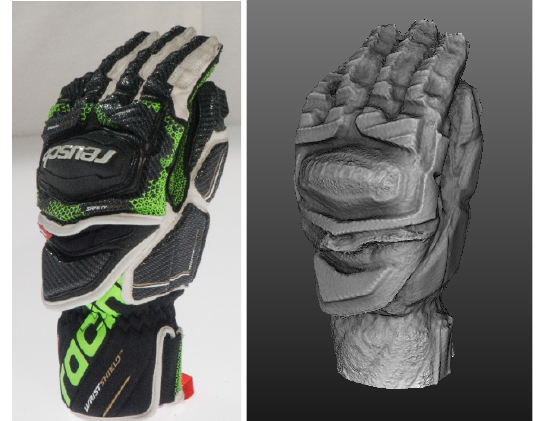
Figure 13: One (out of 93) image of a glove obtained by rotating the system basement around the Z axis (left) and the reconstructed 3D mesh through photogrammetric process